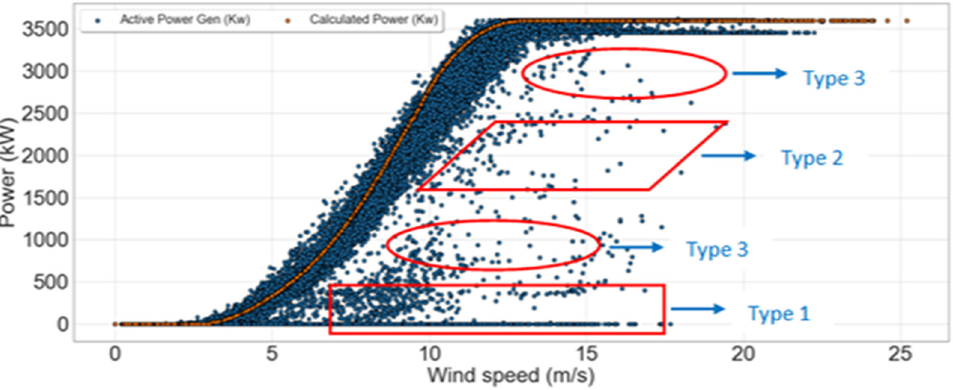
Figure 3. Wind speed vs. power curve with the raw